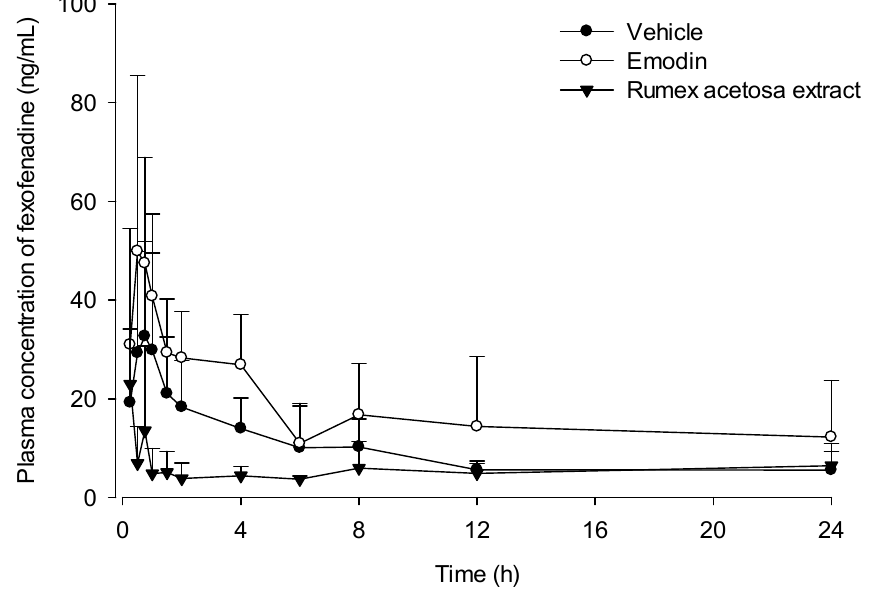
Figure 5. Mean plasma concentration–time profiles of fexofenadine (ng/mL) after oral coadministration of fexofenadine (10 mg/kg) with vehicle ( ● ; n = 6), emodin (11 mg/ kg, ○ ; n = 6) and R. acetosa extract (2 g/kg, ▼ ; n = 6) to rats. Bars represent standard deviations. Table 1. Pharmacokinetic parameters of fexofenadine after oral coadministration of fexofenadine (10 mg/kg) with vehicle (control), emodin and R. acetosa extract to rats. Values represent means ± standard deviations for AUC 0-24 h and C max (ng/mL), median (range) for T max . Parameters